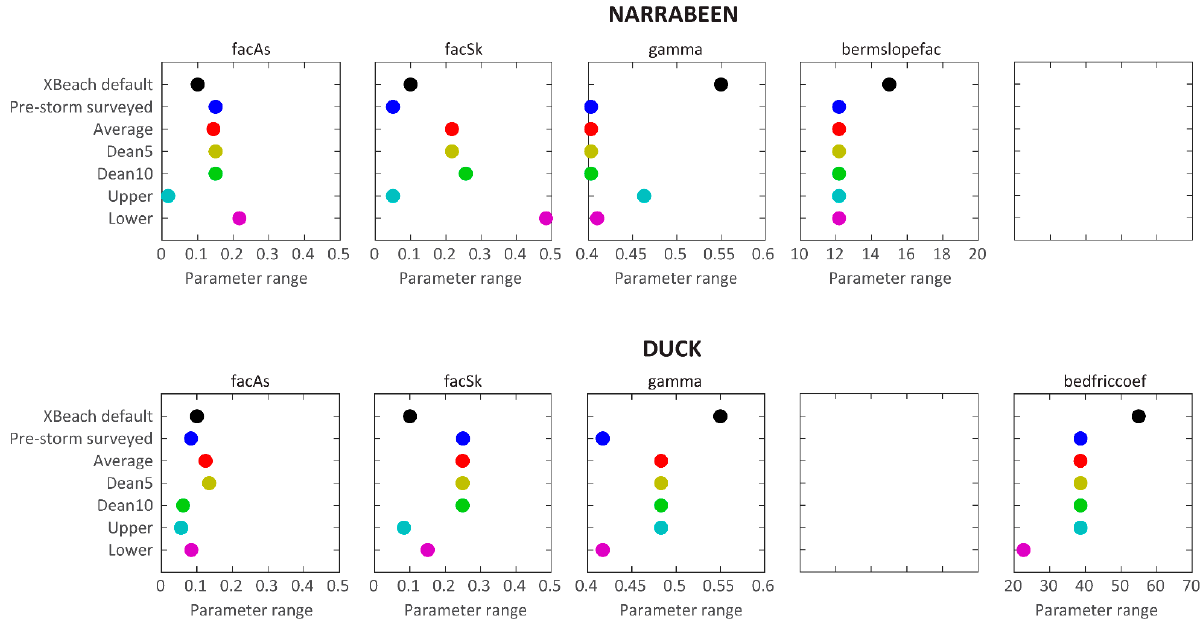
Figure 8. Optimal parameter values for Narrabeen ( top ) and Duck ( bottom ) as a function of the bathymetry used in the calibration process. Note that the bermslopefac and bedfriccoef are only used for calibration at Narrabeen and Duck, respectively, and, hence, left blank where not applied.